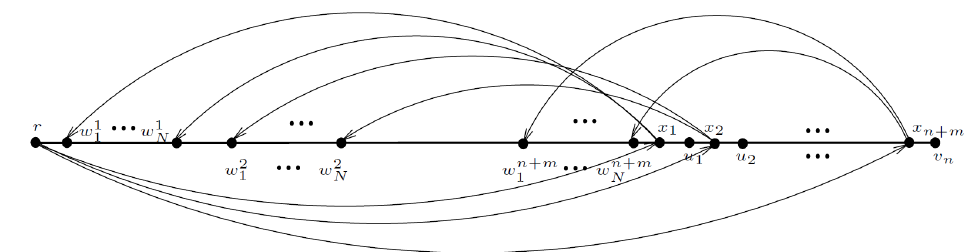
Figure 6. The reduction of Theorem 7. The unweighted fixed-cost path (in bold) is directed from r to v n . For the sake of clarity, only priceable edges in P 1 are